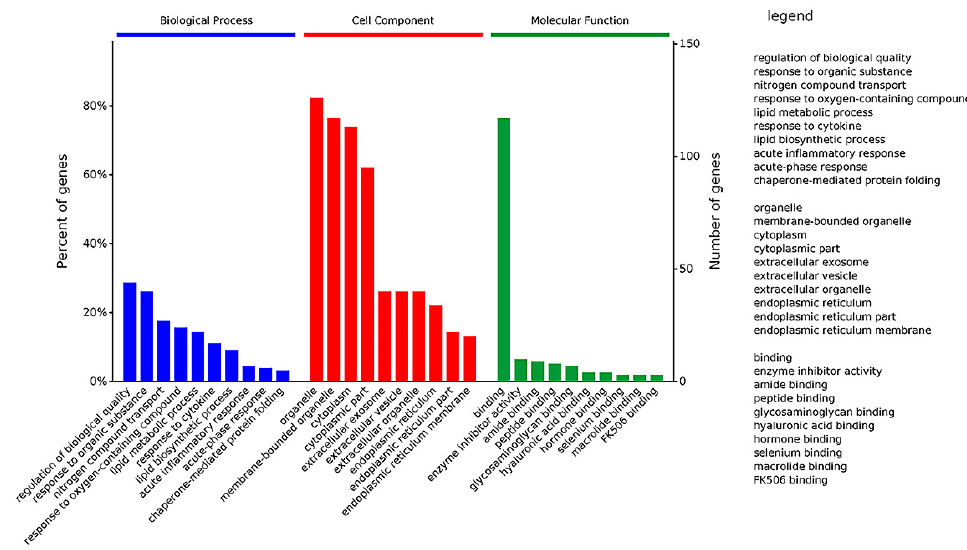
Figure 9. GO classification of DEPs. The DEPs were divided into three GO terms: Biological Process, Cell Component and Molecular Function.